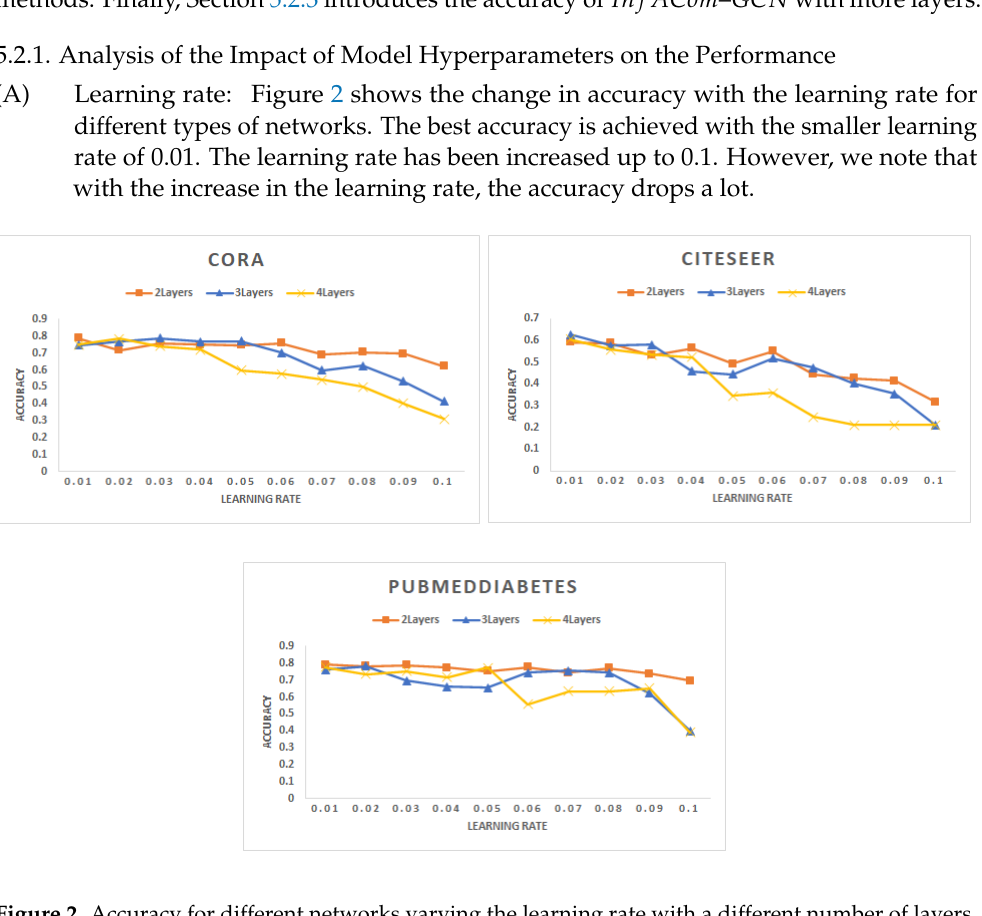
Figure 2. Accuracy for different networks varying the learning rate with a different number of layers.